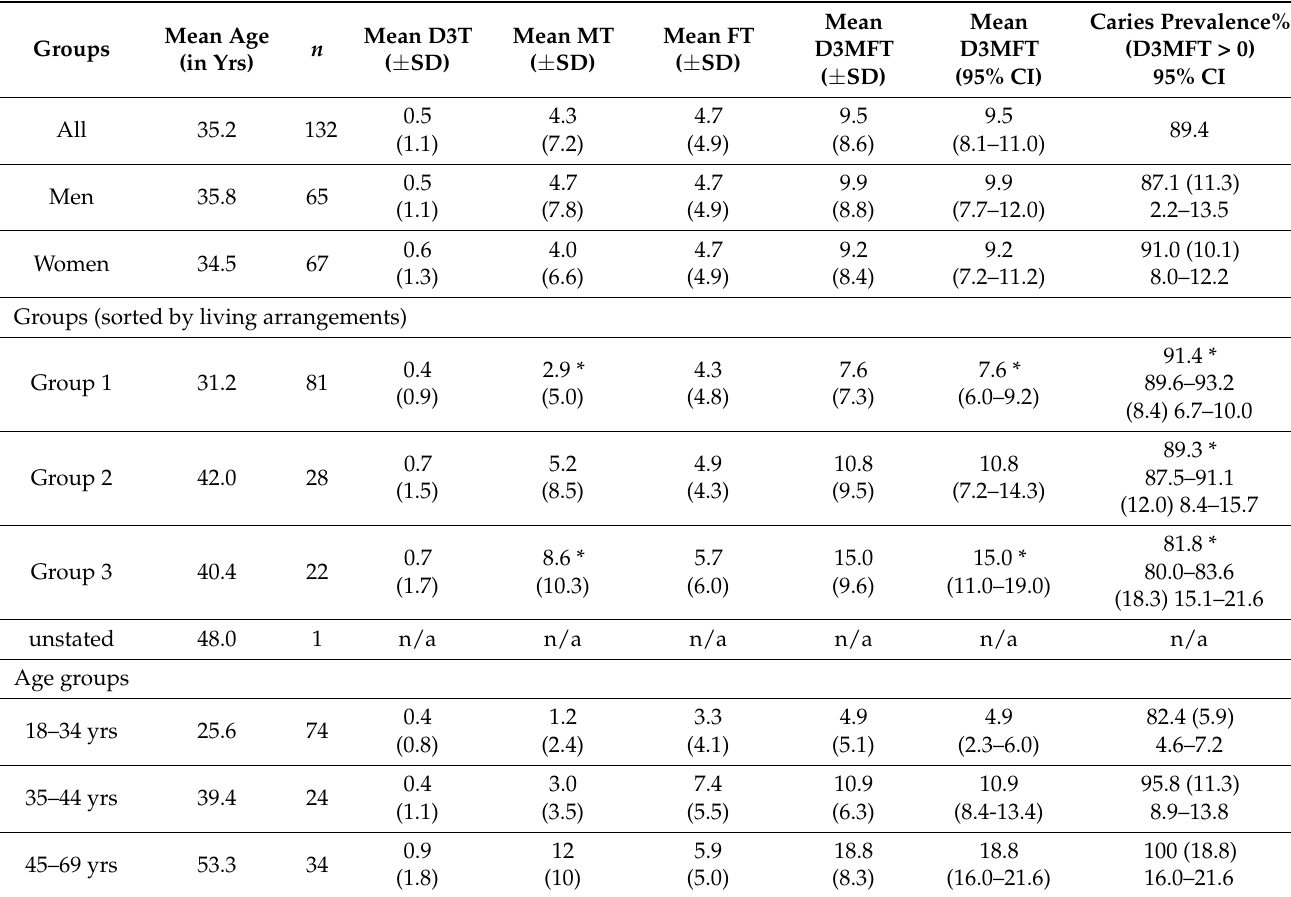
Table 3. Mean DT, MT, FT and D3MFT values and standard deviation (SD) according to the participant’s age group, gender and living